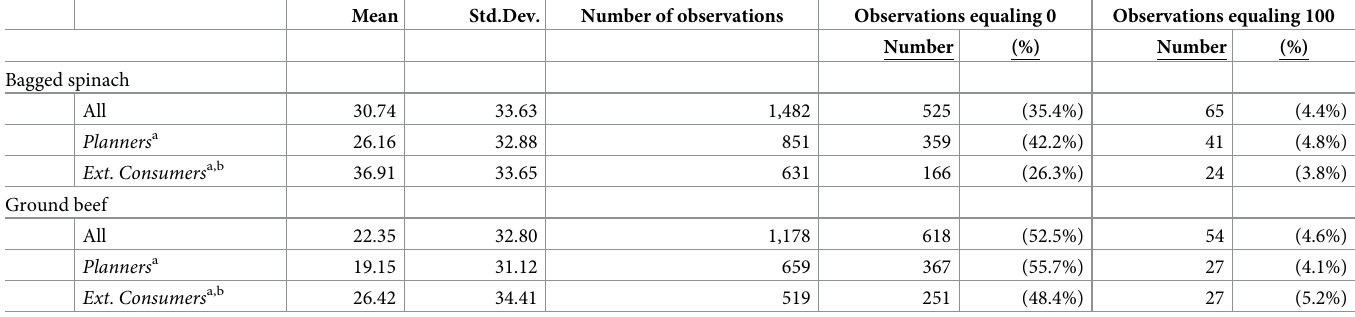
Table 2. Summary statistics of food waste tendency (score of 0 to